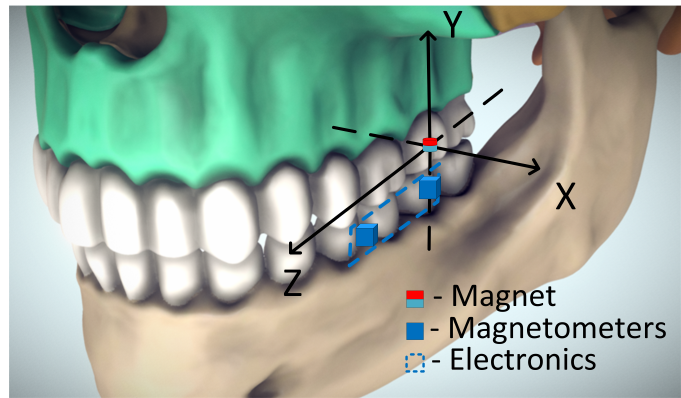
Figure 1. Illustration of the concept of the method. Based on